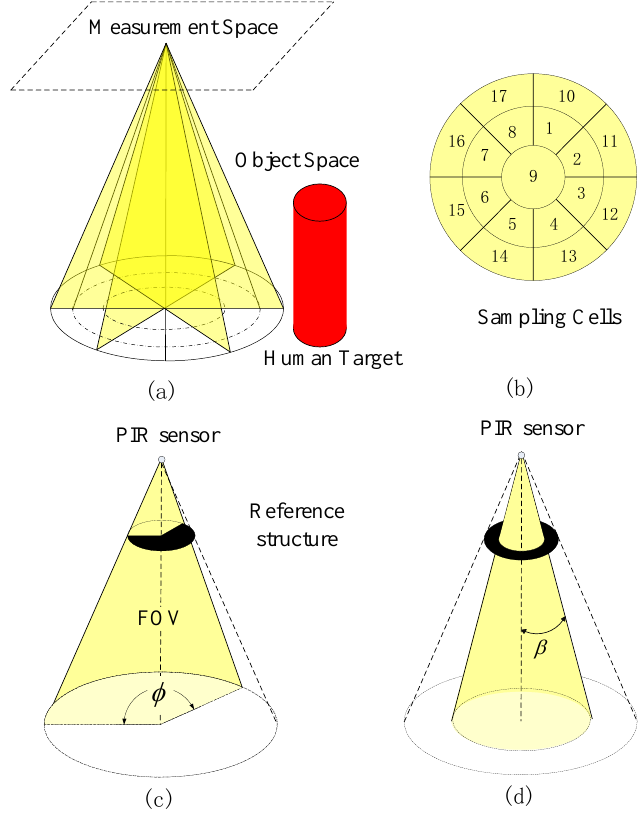
Figure 1. Sensing model design: ( a ) Measurement space, object space and the human thermal target; ( b ) The projection of sampling cells on the ground; ( c ) Type I mask; ( d ) Type II